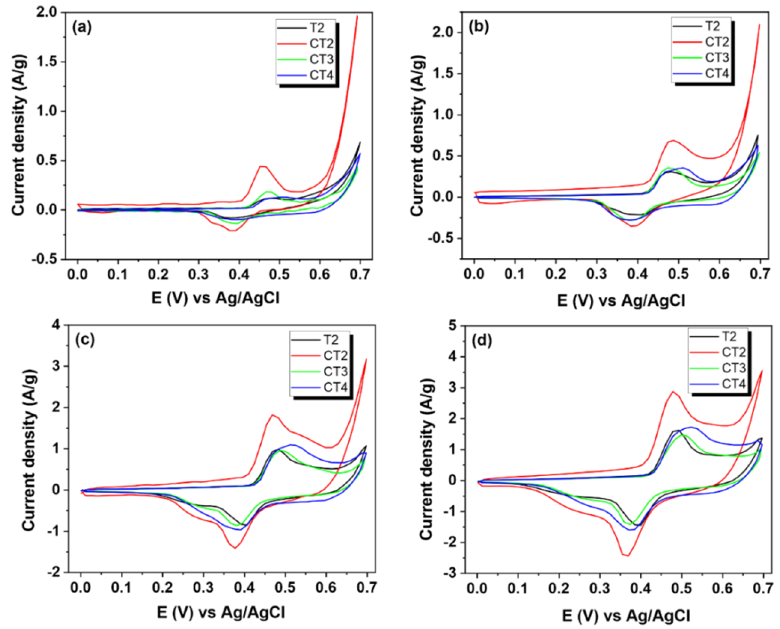
Figure 5. Cyclic voltammetry curves for TiO 2 (T2) and Cu (0.5%, 1%, 2%)-doped TiO 2 (CT2-CT4) recorded at 25 mV/s ( a ); 50 mV/s ( b ); 150 mV/s ( c ); and 250 mV/s ( d ) scan rates.